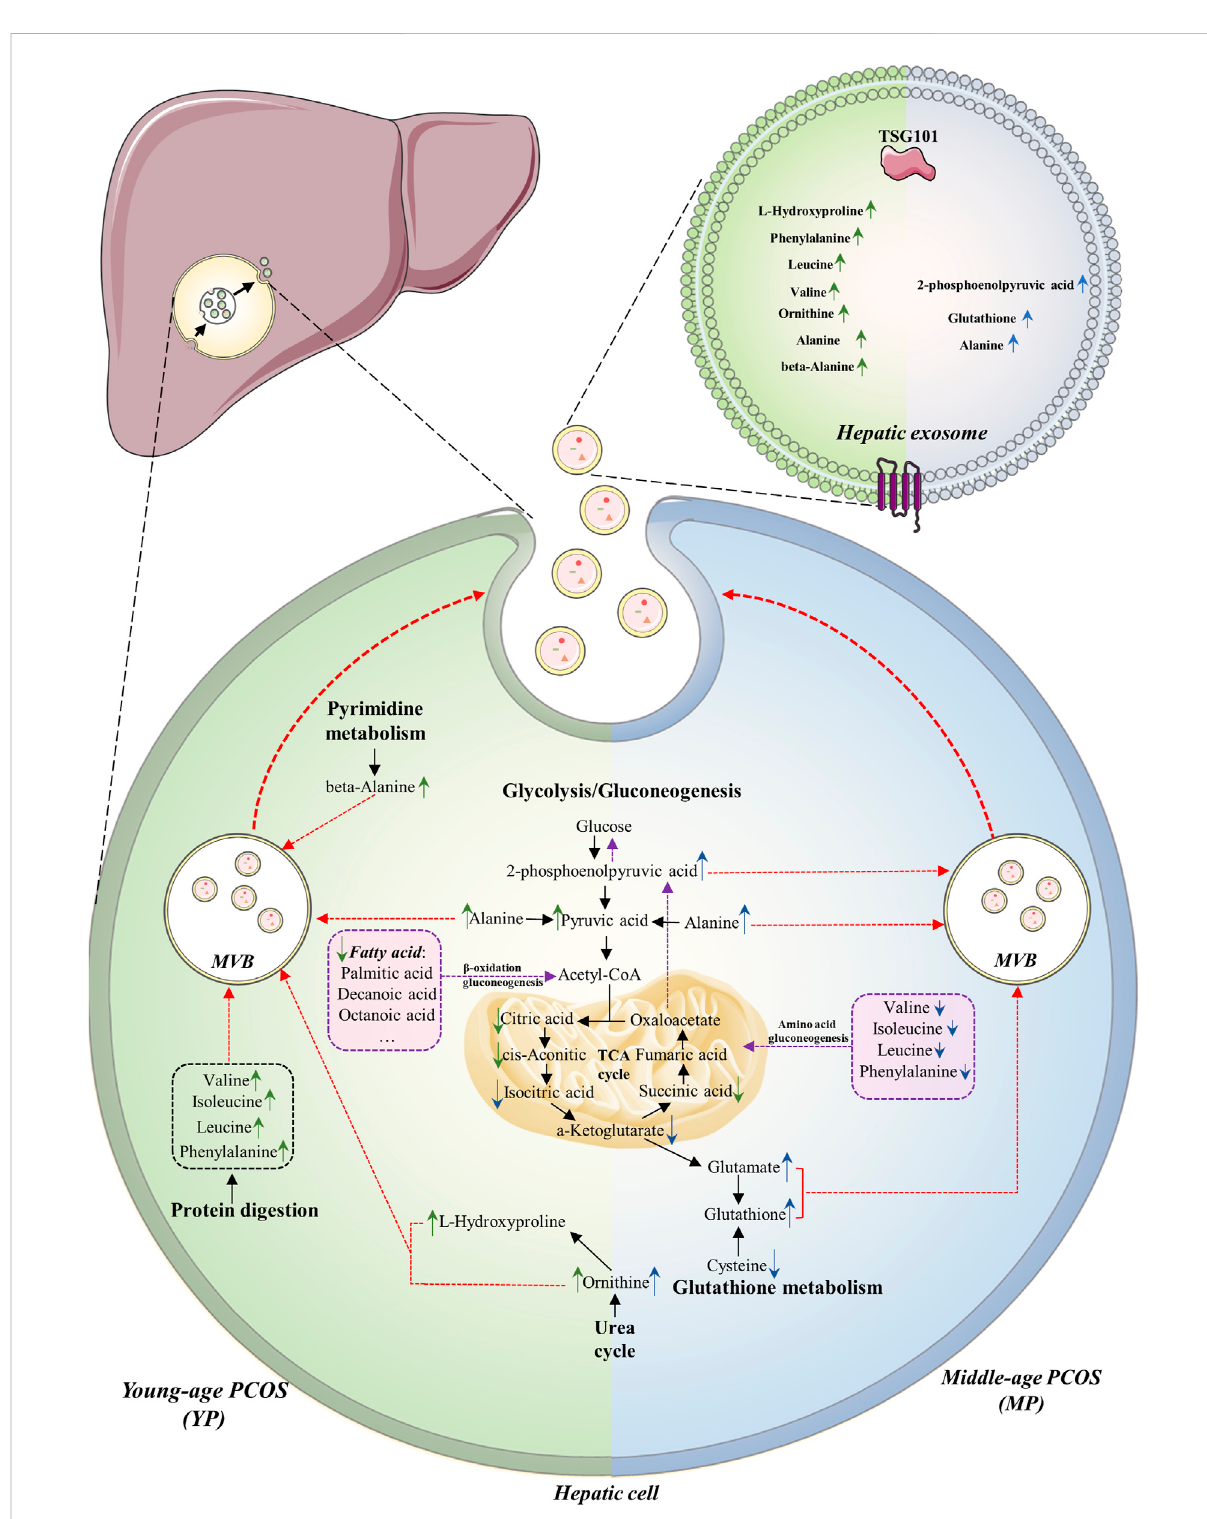
FIGURE 6 Summary of altered metabolitesand metabolic pathways inthisstudy.The metabolome ofliver tissue andhepatic exosomesinPCOS between young (YP, left green part) and middleage (MP, blue right part) are compared. The commonalterations ofthe two age groups are downregulation of glycolysis and TCA cycle, as well as upregulation of gluconeogenesis. The major substrates for gluconeogenesis in YP and MP hepatic cells are fatty acids and amino acids, respectively (purple boxes). In YP hepatic cells, the urea cycle, protein digestion and pyrimidine metabolism seem to be upregulated, while the glutathione metabolism seems to be upregulated in MP hepatic cells. The arrows indicate up- or down-regulation of metabolites in (green) young- or (blue) middle-age groups detected in the liver or exosomes. The purple dotted lines indicate the gluconeogenesis pathway in hepatic cells. The red dotted lines indicate the processes in which the elevated metabolic products are transported into